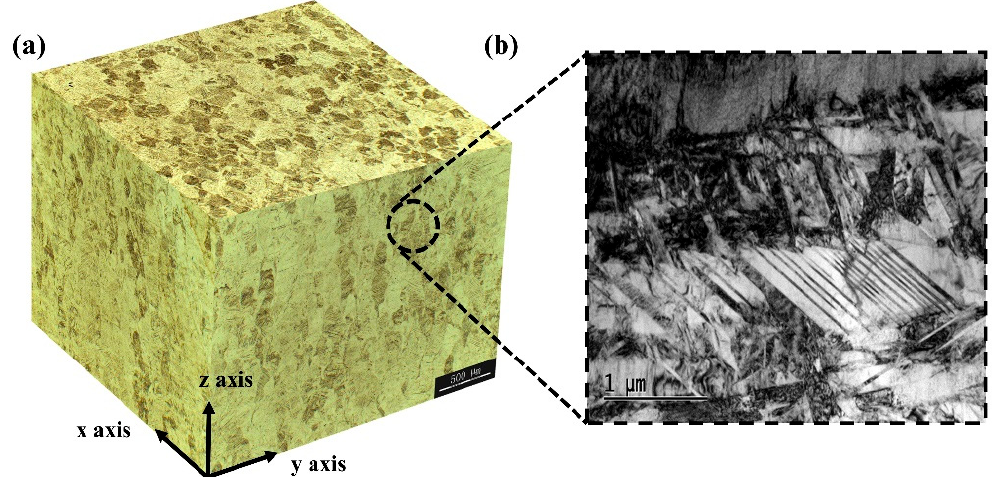
Figure3. Themicrostructureoftheas-builtTi–6Al–4Valloy: ( a )3Dopticalmicroscope(OM)microstructure, Figure 3. The microstructure of the as ‐ built Ti–6Al–4V alloy: ( a ) 3D optical microscope (OM) ( b )transmission electron microscope (TEM)microstructure. The z -axisdirectionis thebuilding microstructure, ( b ) transmission electron microscope (TEM) microstructure. The z ‐ axis direction is the building direction.